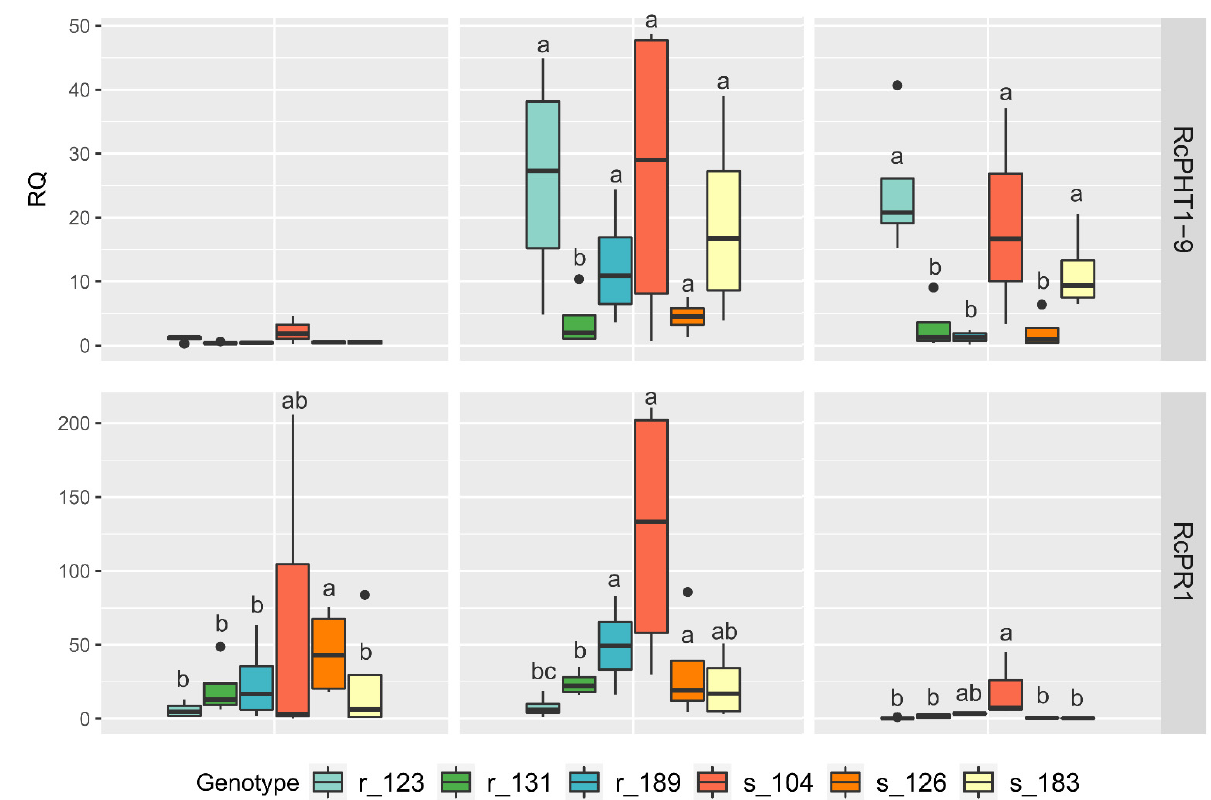
Figure 7. RT-qPCR analysis of a combined stress experiment in leaves of six 97/7 rose genotypes at 3 dpi. Two Pi treatments (“fullPi” and “starvPi”) and additional inoculation with D. rosae (“D4”). Expression changes of each genotype relative to “H 2 O_fullPi”. Data are represented as boxplots of RQ values (relative quantification = 2 − ∆∆ Ct ). The letters indicate groups of genotypes whose gene expressions differed significantly within a treatment (REST). The expression changes caused by the different treatments for each genotype are shown in Table S5. r: resistant, s: susceptible genotype, n = 4.